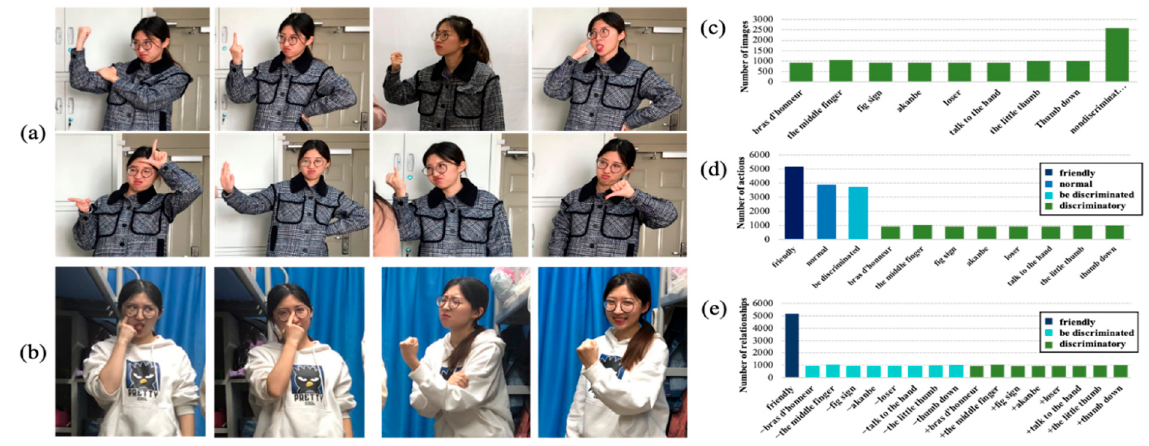
Figure 4. Discriminative Action Relational Image dataset (DARIdata). ( a ) Eight types of discriminatory actions summarized in DARIdata. The first line shows bras d’honneur, the middle finger, fig sign, akanbe; the second line shows the loser, talk to the hand, the little thumb, and thumb down. ( b ) Examples of interference images: akanbe-pushing glasses, bras d’honneur-encouragement. ( c ) Distribution of images per category. ( d ) The number of actions per category. ( e ) The number of relationships per category. - indicates be discriminated, + indicates discriminatory.